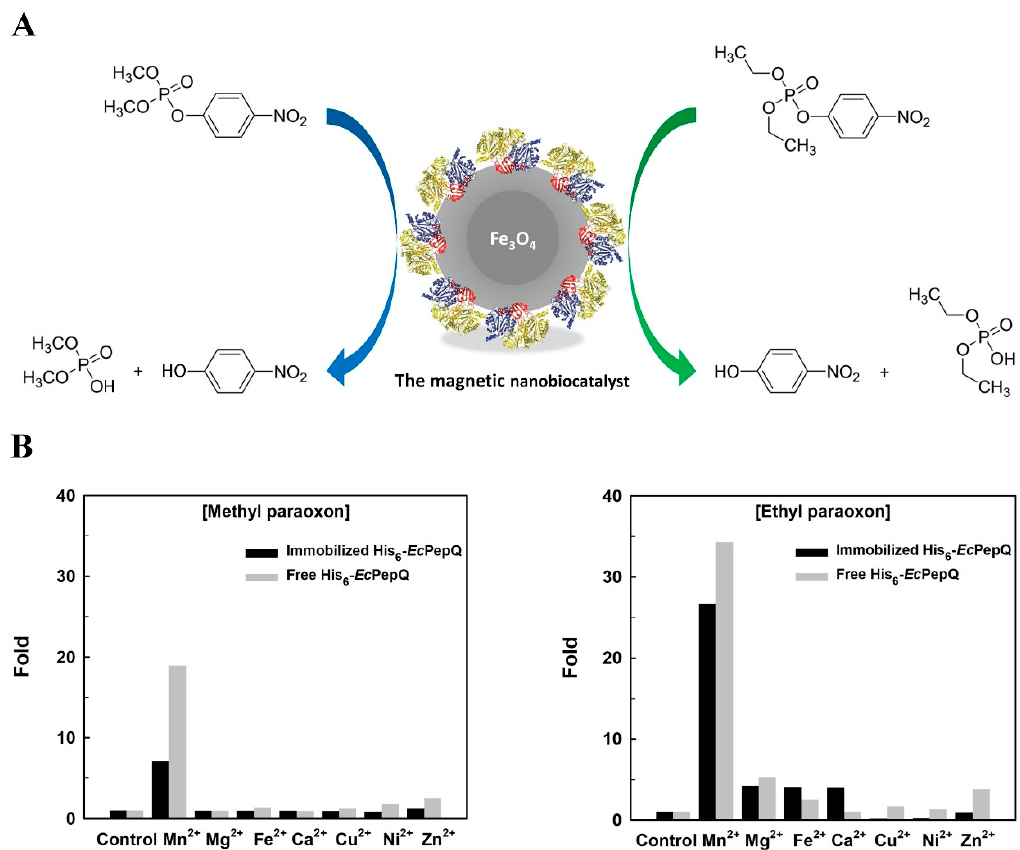
Figure 7. Schematic illustration of the enzymatic hydrolysis of methyl paraoxon and ethyl paraoxon by His 6 - Ec PepQ@NiNTAMPNs ( A ), and effects of different divalent metal ions on their hydrolysis ( B ). Table 1. Kinetic parameters of free and immobilized